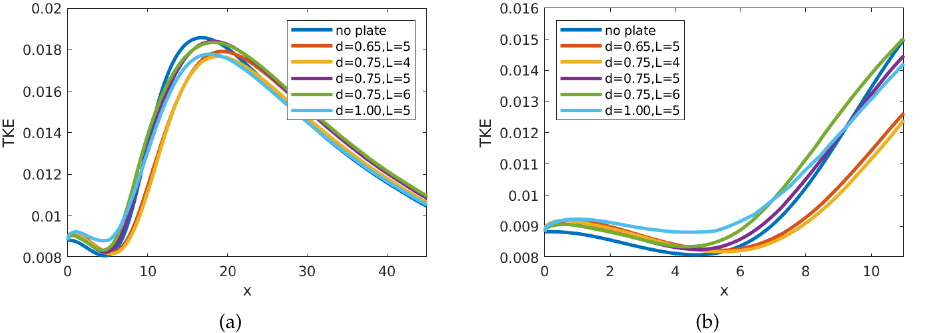
Figure 4. Turbulent kinetic energy along the jet centerline from RANS: ( a ) x from 0 to 45; ( b ) details in the core region with x from 0 to